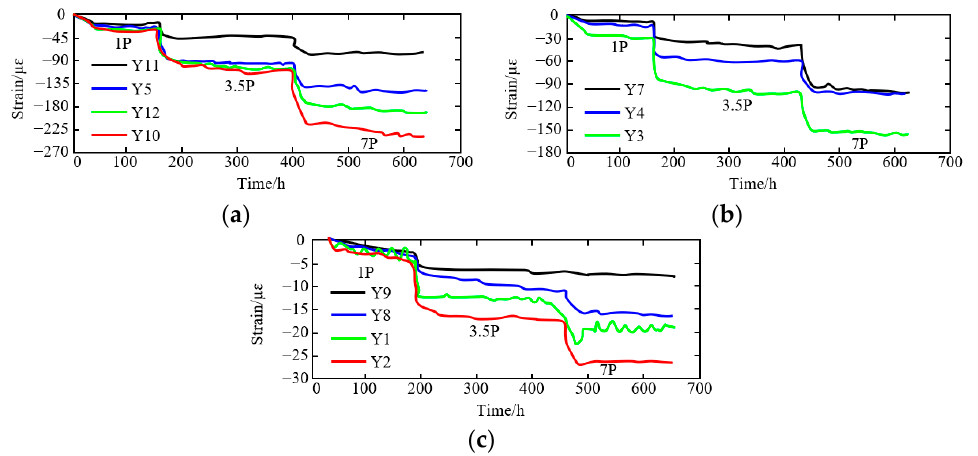
Figure 15. Strain gauge deformation–time curve: ( a ) back anchor surface; ( b ) middle anchor; ( c ) front anchor. Table 3. Flow deformation of strain gauge.